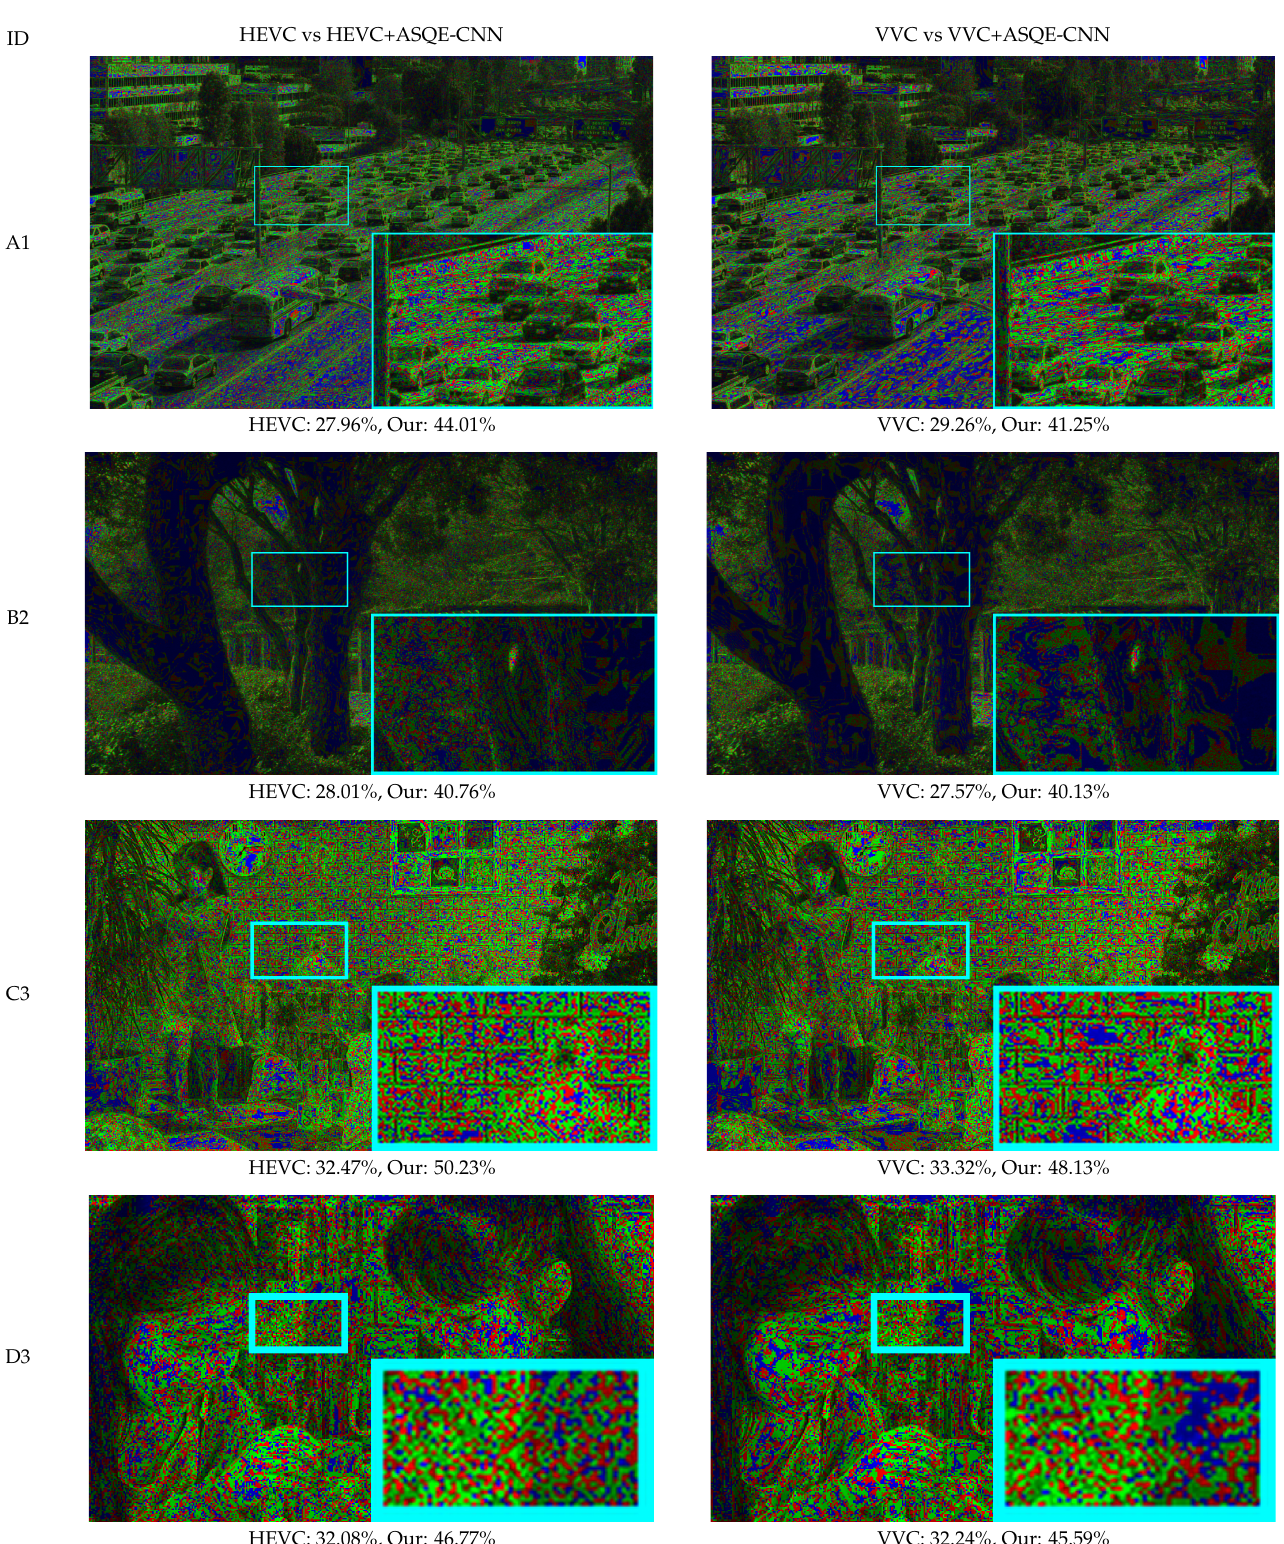
Figure 12. Pseudo-colored image comparison. Green marks the pixel positions where ASQE-CNN achieves better performance. Blue marks the pixel positions where the methods have the same performance. Red marks the pixel positions where HEVC/VVC achieves better performance. The bottom-right corner of each image presents the zoom in of the RoI marked by the cyan